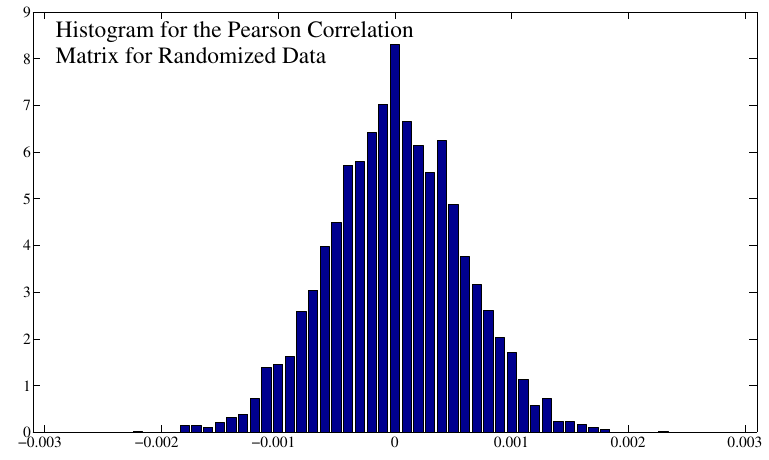
Figure 24. Histograms of the elements of the correlation matrix obtained as the average of ten Pearson correlation matrices of simulations with randomized data, where the diagonal terms (always equal to 1) have been